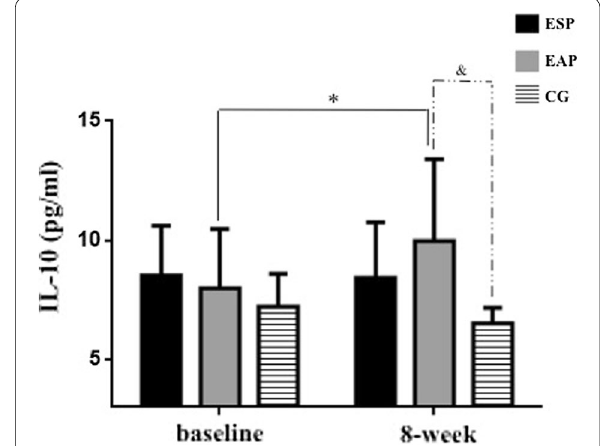
ESP exercise and sham PBM group, EAP exercise and active PBM group, CG control group, WOMAC: Western Ontario and McMaster Universities Osteoarthritis * statistical significance between in the baseline and in the 8-week a statistical significance from ESP group in the same condition b statistical significance from EAP group in the same condition